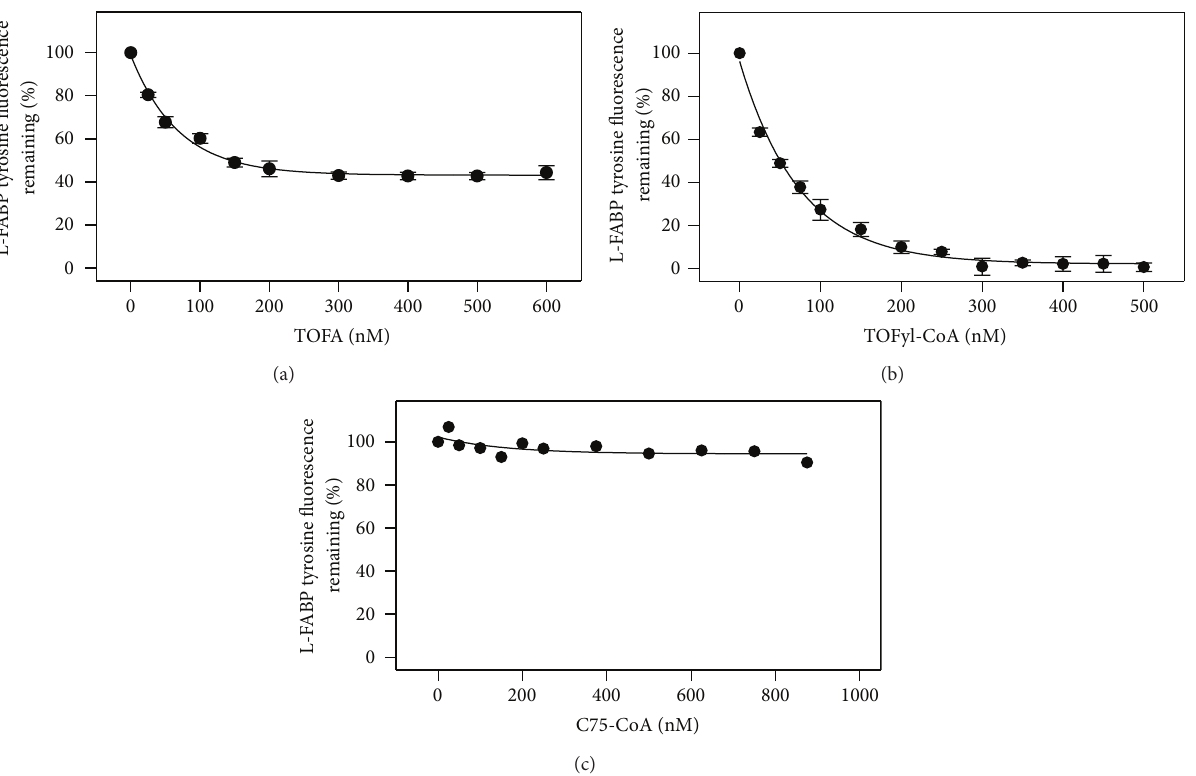
Figure8:TOFA,TOFyl-CoA,andC75-CoAbindingtoL-FABPasdeterminedbyquenchingofintrinsicL-FABPtyrosinequenching.L-FABP tyrosine quenching by TOFA (panel a), TOFyl-CoA (panel b), and C75-CoA (panel c) was determined as described in Methods. Tyrosine fluorescence emission of L-FABP (100nM) in 10mM phosphate buffer (pH = 7.4) was monitored by scanning from 290 to 400nm, with excitation wavelength 280nm, before and after small increments of added binding ligand. The binding curve was constructed by plotting percentage of tyrosine fluorescence intensity remaining at 305 nm versus concentration of the ligand. Panel (a) and (b), mean ± SEM, 𝑛 = 3